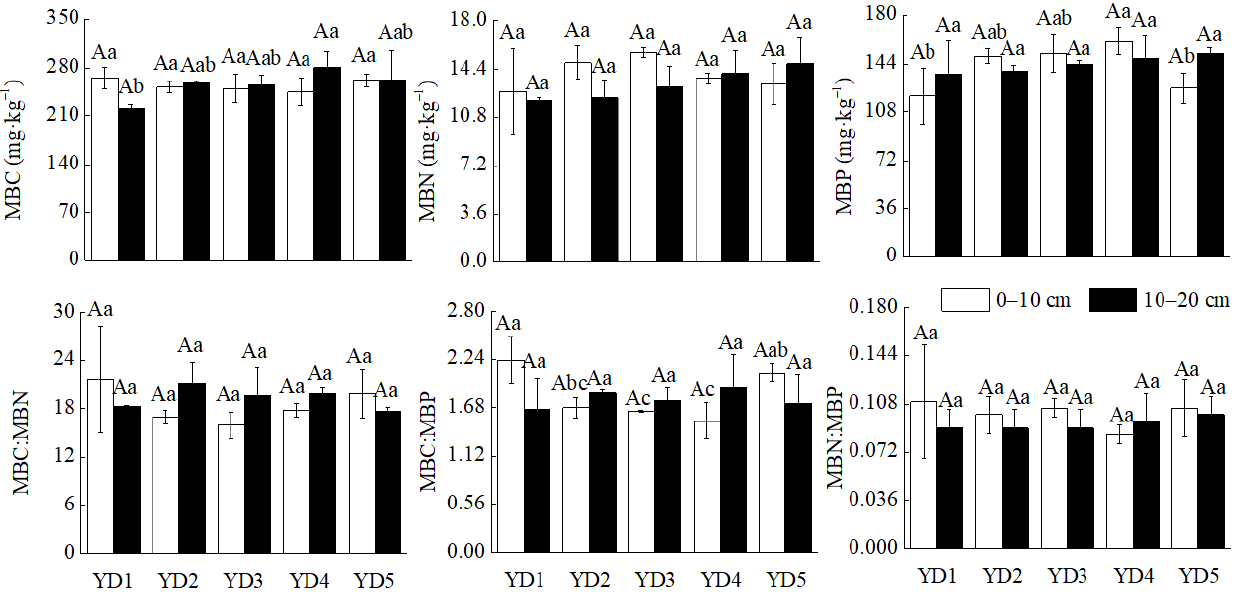
Figure 4. Soil microbial biomass and stoichiometry of Z. planispinum plantations. MBC, soil microbial biomass carbon; MBN, soil microbial biomass nitrogen; MBP, soil microbial biomass phosphorus; MBC:MBN, soil microbial biomass carbon to microbial biomass nitrogen ratio; MBC:MBP, soil microbial biomass carbon to microbial biomass phosphorus ratio; MBN:MBP, soil microbial biomass nitrogen to microbial biomass phosphorus ratio. Lower case letters, significant differences between different plantation types of the same depth at p < 0.05; upper case letters, significant differences between different depths of the same plantation types at p < 0.05.